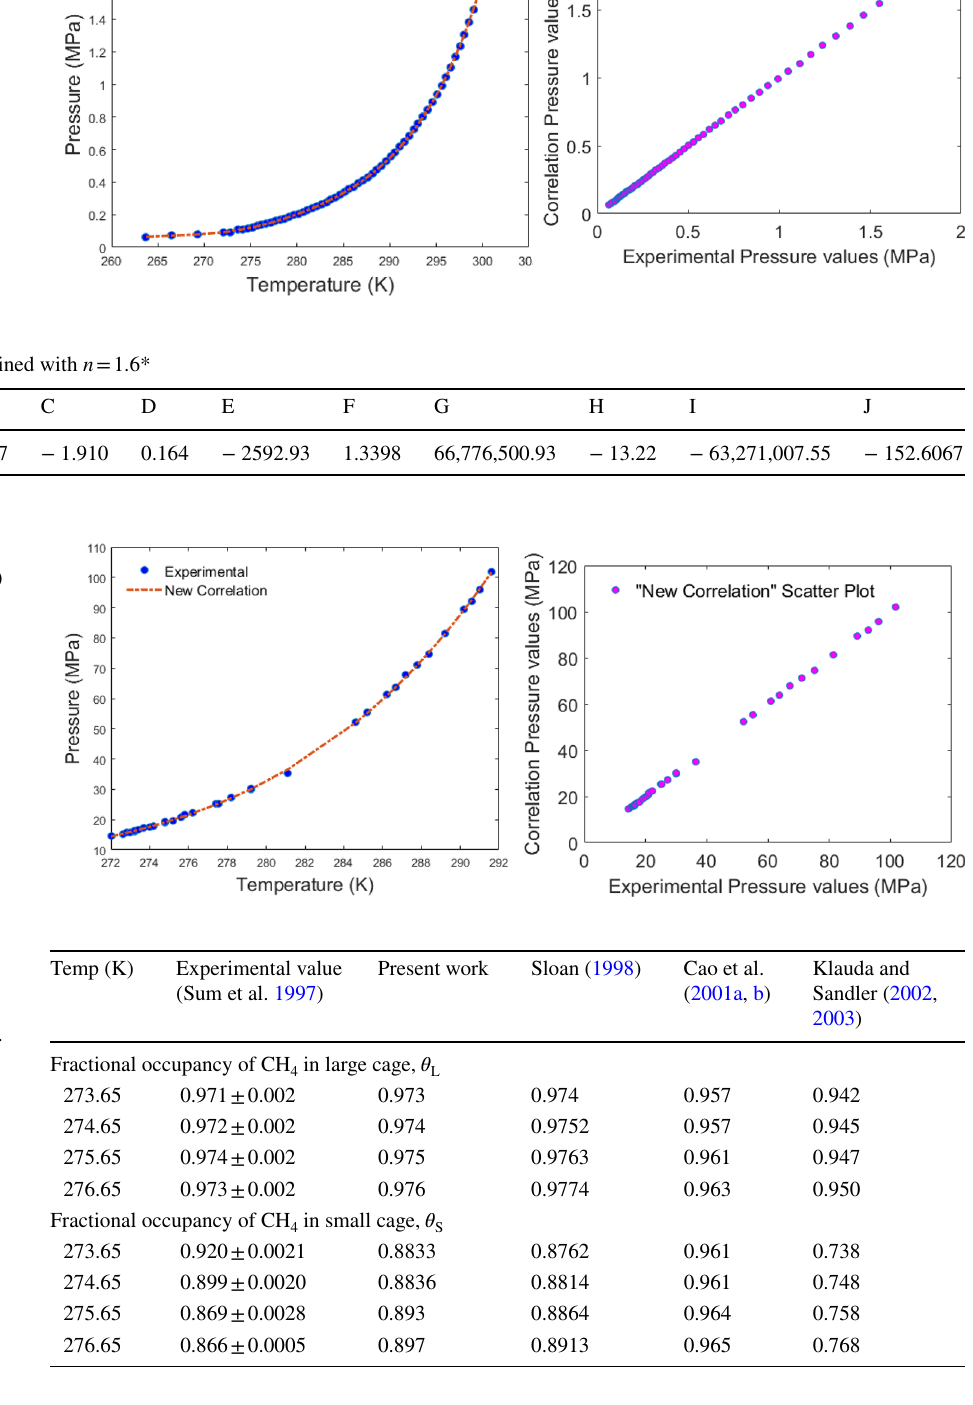
Fig. 18 Peq versus T plot of experimental data (H 2 S hydrates) with “new correla- tion,” AAD = 0.64%